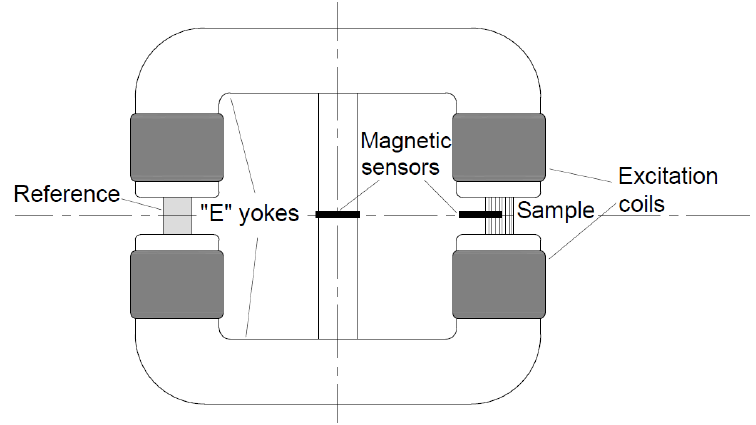
Figure 7. Set-up of the DC magnetometer.